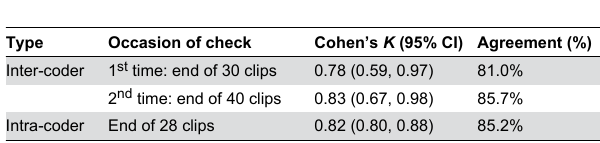
Table 2. Results of inter- and intra-coder reliability ( n =